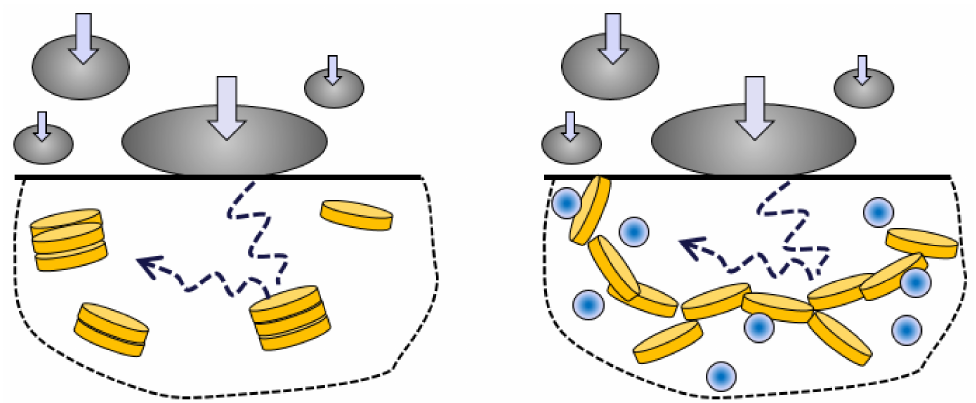
Figure 1. Schema of stress waves reflection and scattering in the coating reinforced by graphene particles (left) and hybrid particles (right) (with anticipated better dispersion and particle